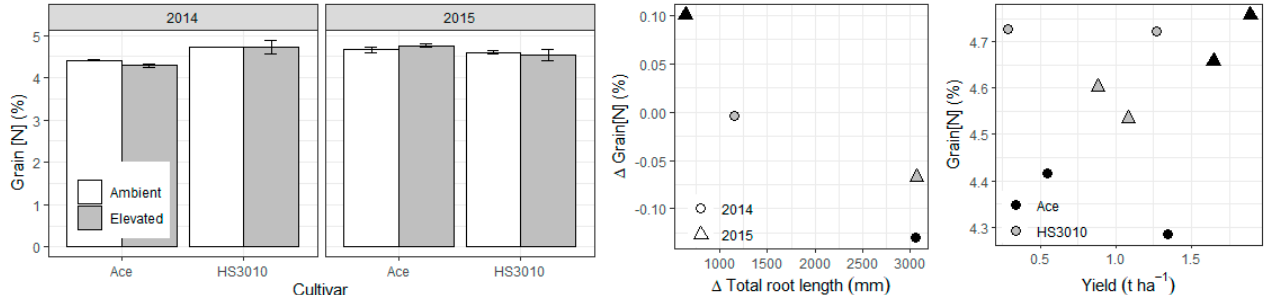
Figure 4. Grain [N] means over CO 2 treatments by years and cultivars in lentil and selected relationships with increases in total root length at 0-15 cm and grain yield. Barplot is a re-analysis of the data presented in Bourgault et al. [13].